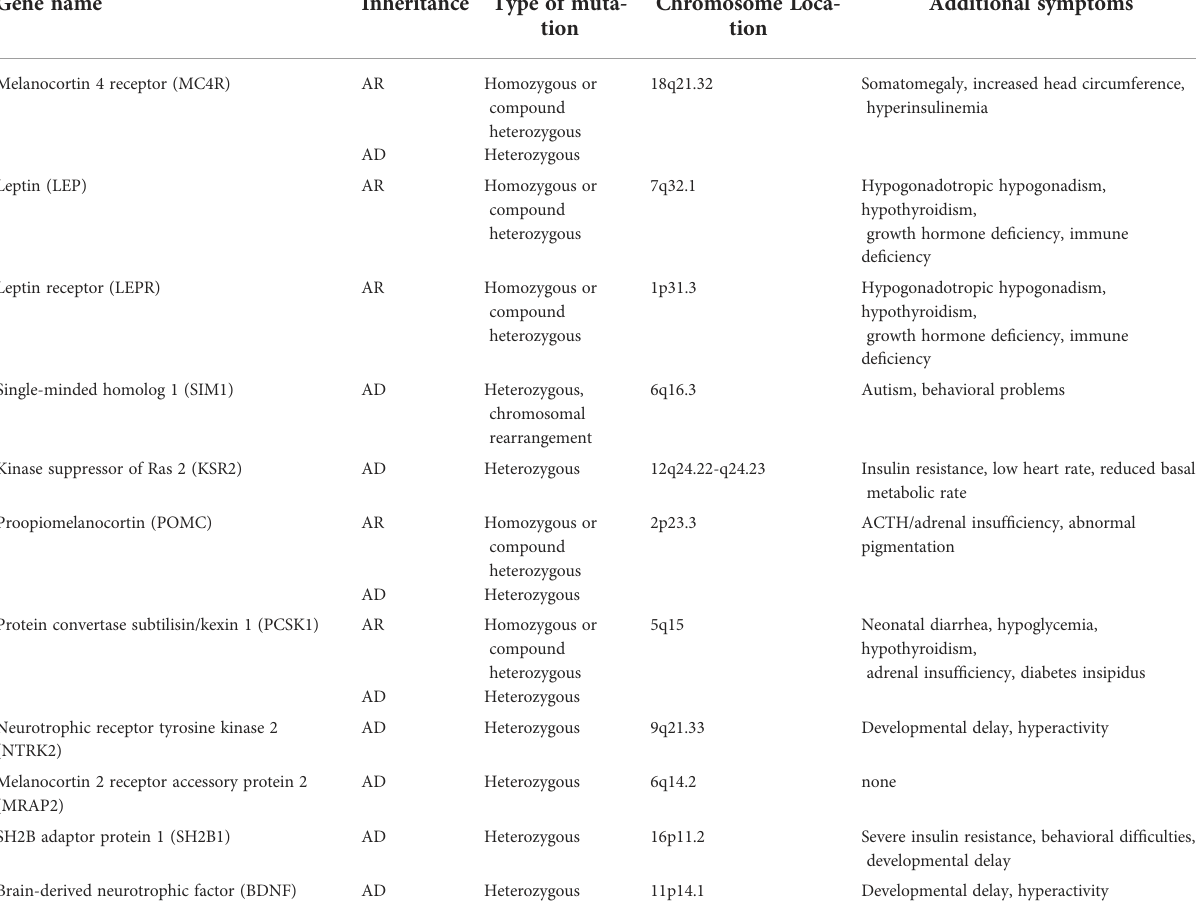
TABLE 1 Most common genes associated with severe early-onset obesity. Gene name Inheritance Type of muta-